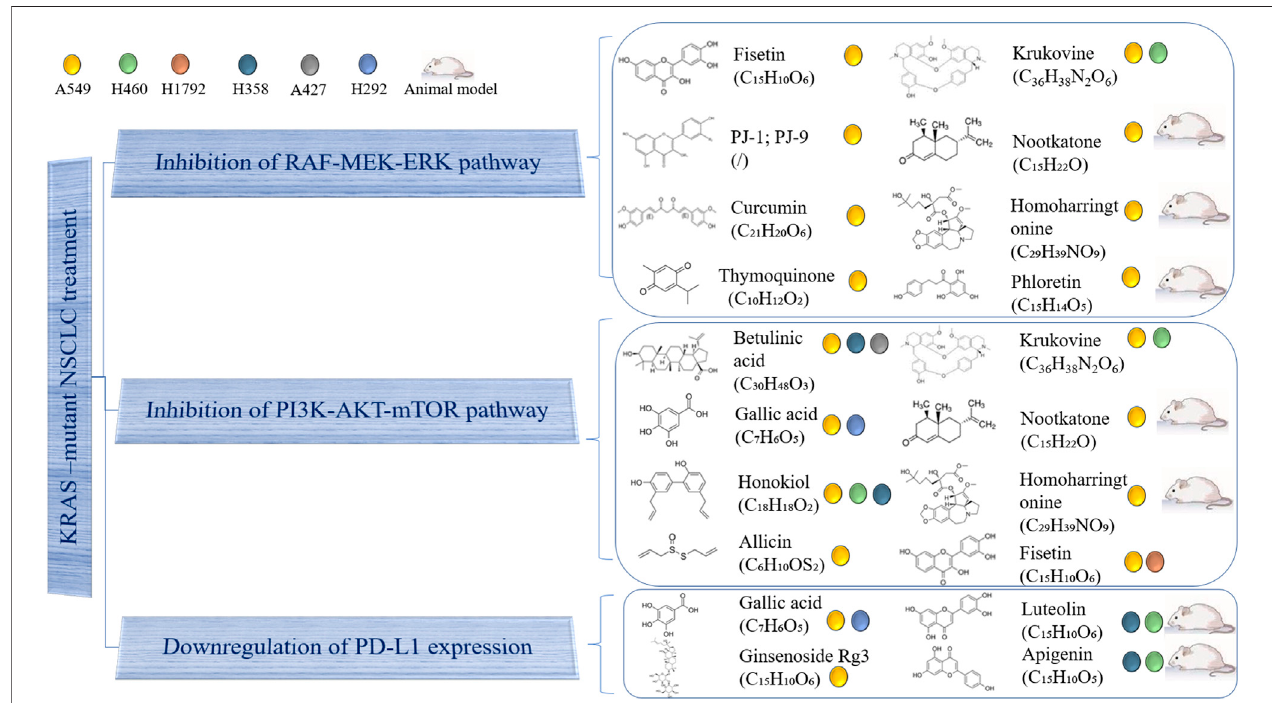
FIGURE2| UseofnaturalcompoundtreatmentofKRAS-mutantNSCLC.Thestructureandchemicalformulaofnaturalcompoundsareclearlypresented.Thecell lines on which natural compounds have an effect are also displayed.